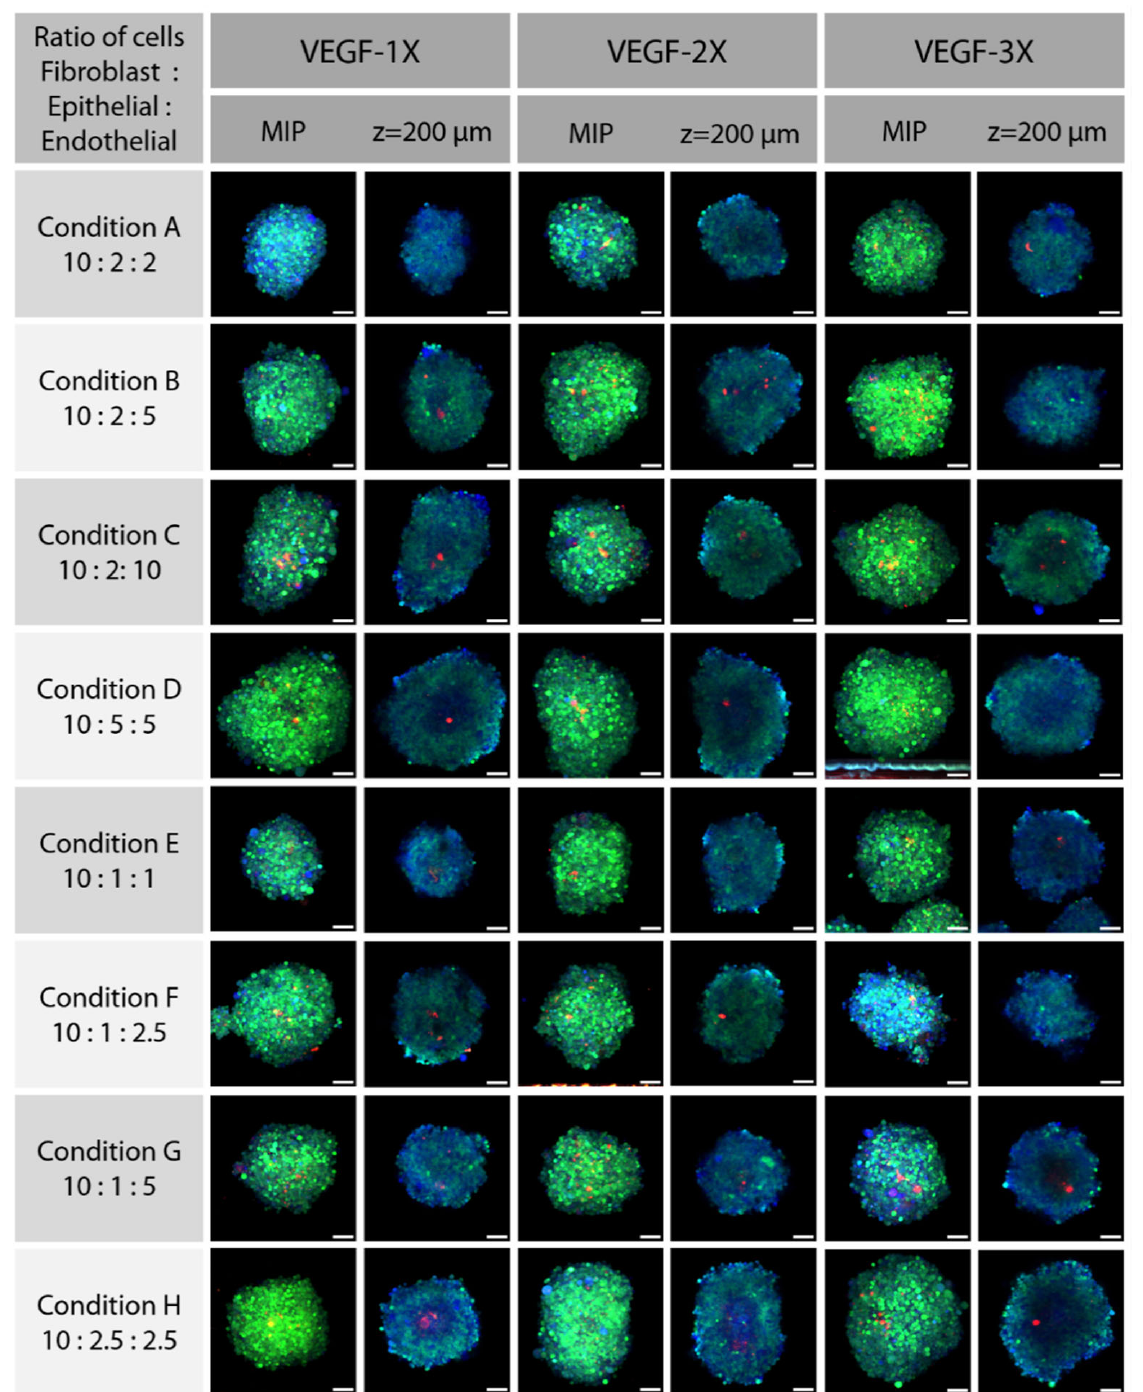
Figure 9. MIP and z-slice (at approximately 2/3 of the whole depth, at z = ~200 µ m, histogram-adjusted) images of the spheroids at conditions described in Table 2, with different VEGF levels. Each whole spheroid is treated with CellTracker Blue; NCI_HFL-1 fibroblast cells were not fluorescent themselves, so they were only blue due to the CellTracker stain. NCI-H1299 cells are fluorescent with GFP, so they show as green to cyan. The HUVEC cells are brightly colored with mCherry, and show as red. The scale bars represent 100 µ m.